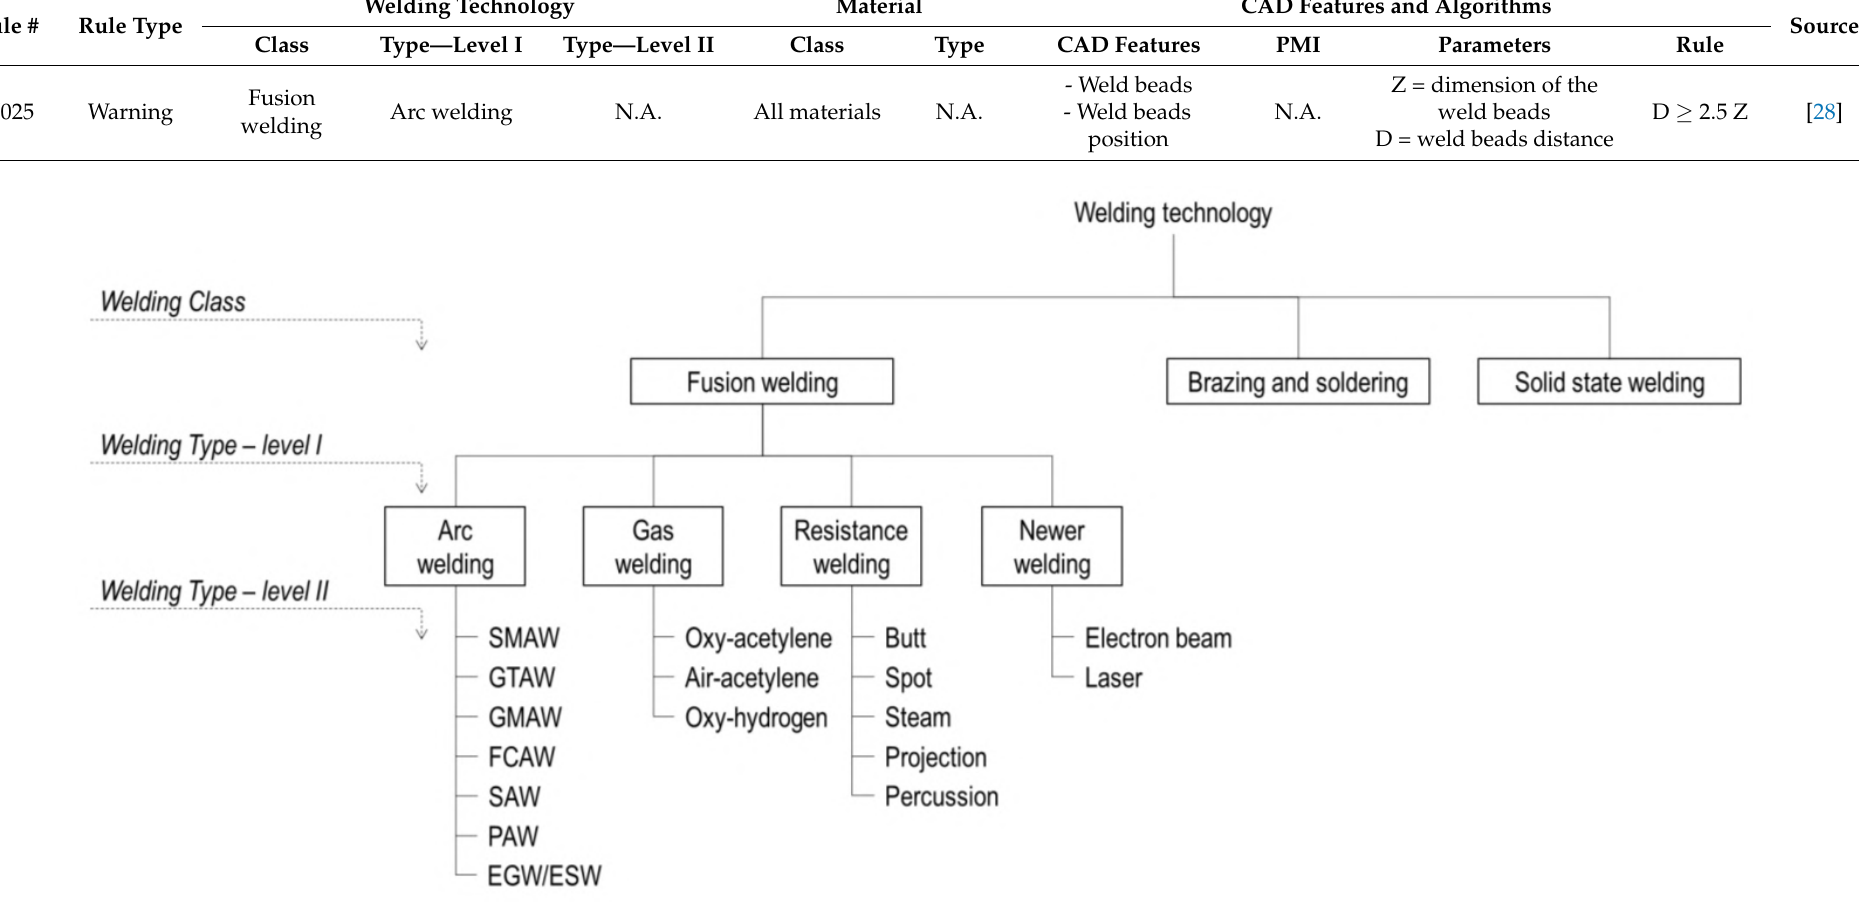
Figure 2. Classification of welding technologies (based on